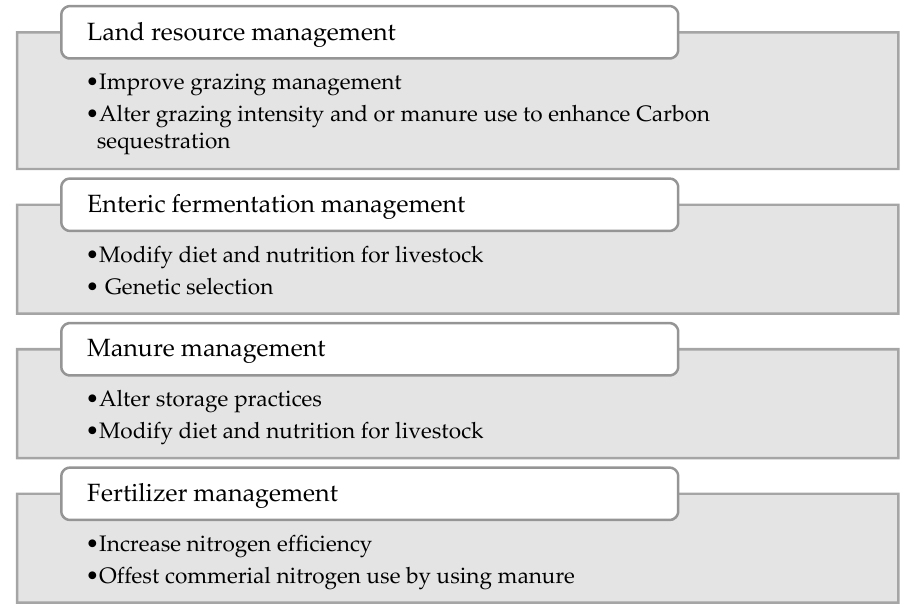
Table 4. Summary of mitigation strategies.